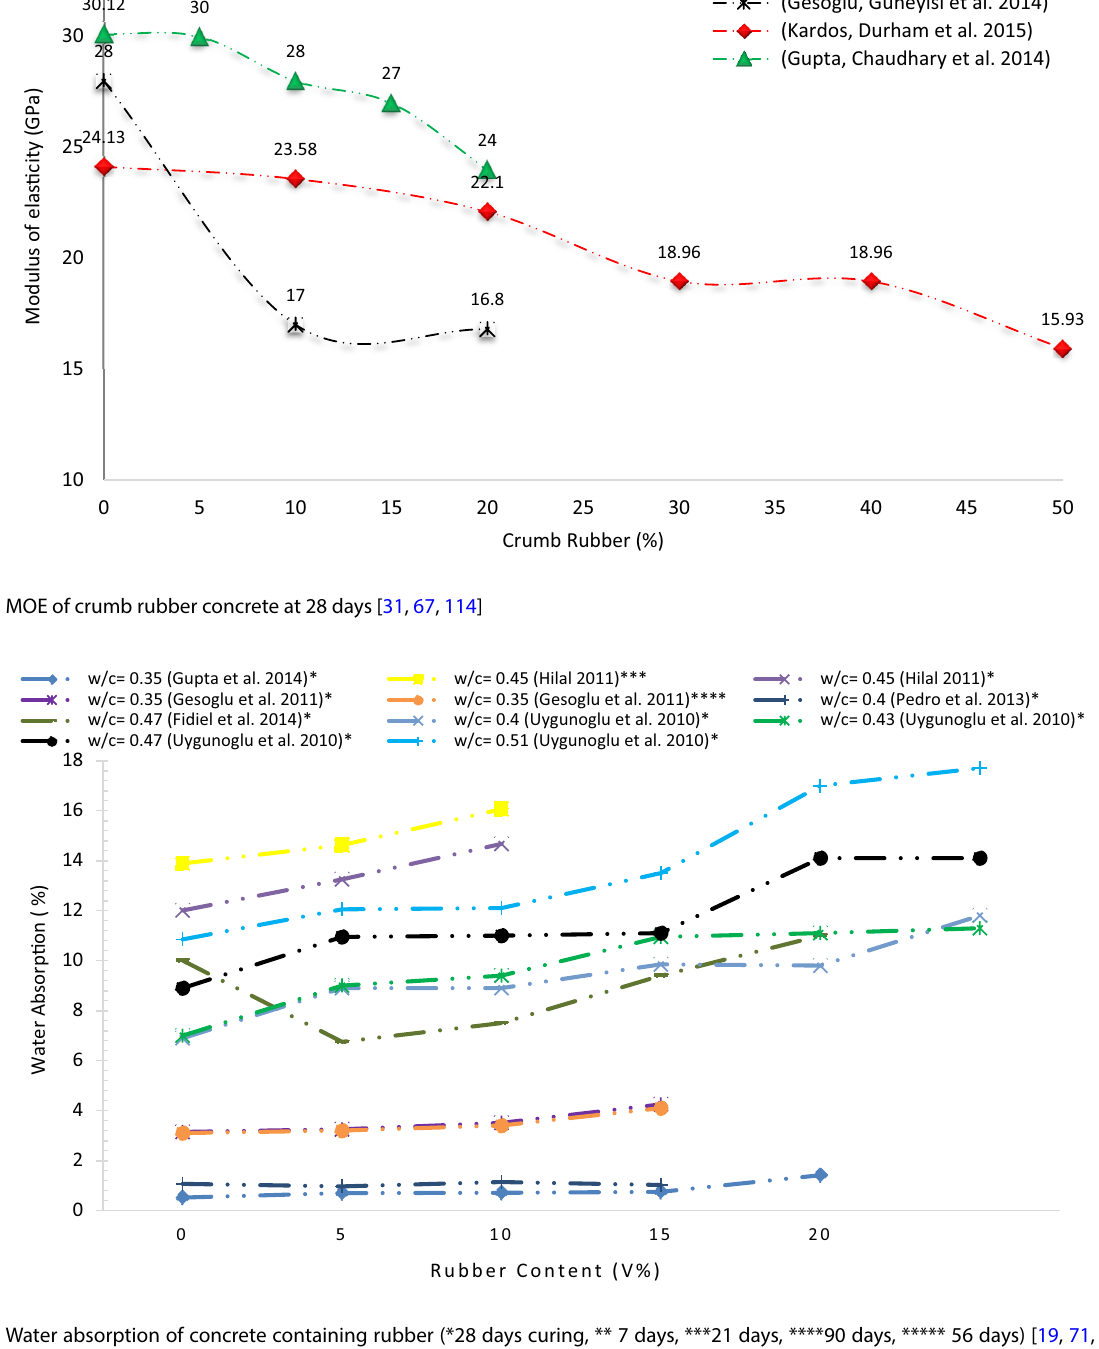
Fig. 16 Water absorption of concrete containing rubber (*28 days curing, ** 7 days, ***21 days, ****90 days, ***** 56 days) [19, 71, 78, 102, 111,